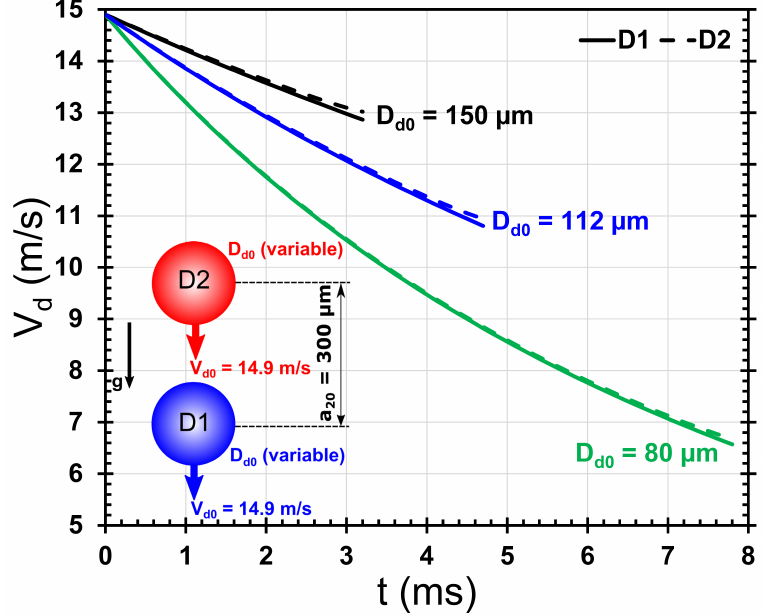
Figure 5. Effect of D d 0 on V d ( t ) : Time evolution of the velocities of leading (D1) and trailing (D2) iso-propanol droplets for three typical cases of droplet diameters, D d 0 = 80, 112, and 150 µ m, as predicted by Equations (11) and (12). Other input parameters are kept the same as in Figure 4: a 20 = 300 µ m; V d 0 = 14.9 m/s; C D is calculated using Equation (10). The initial values of the Reynolds number and aerodynamic Weber number for the three cases (80, 112, 150) µ m are (79.0, 110.6, 148.2) and (0.98, 1.38, 1.84),